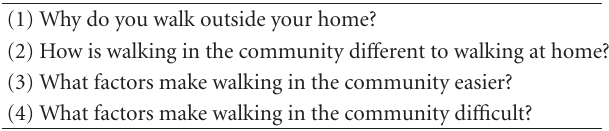
Table 2: Key focus group